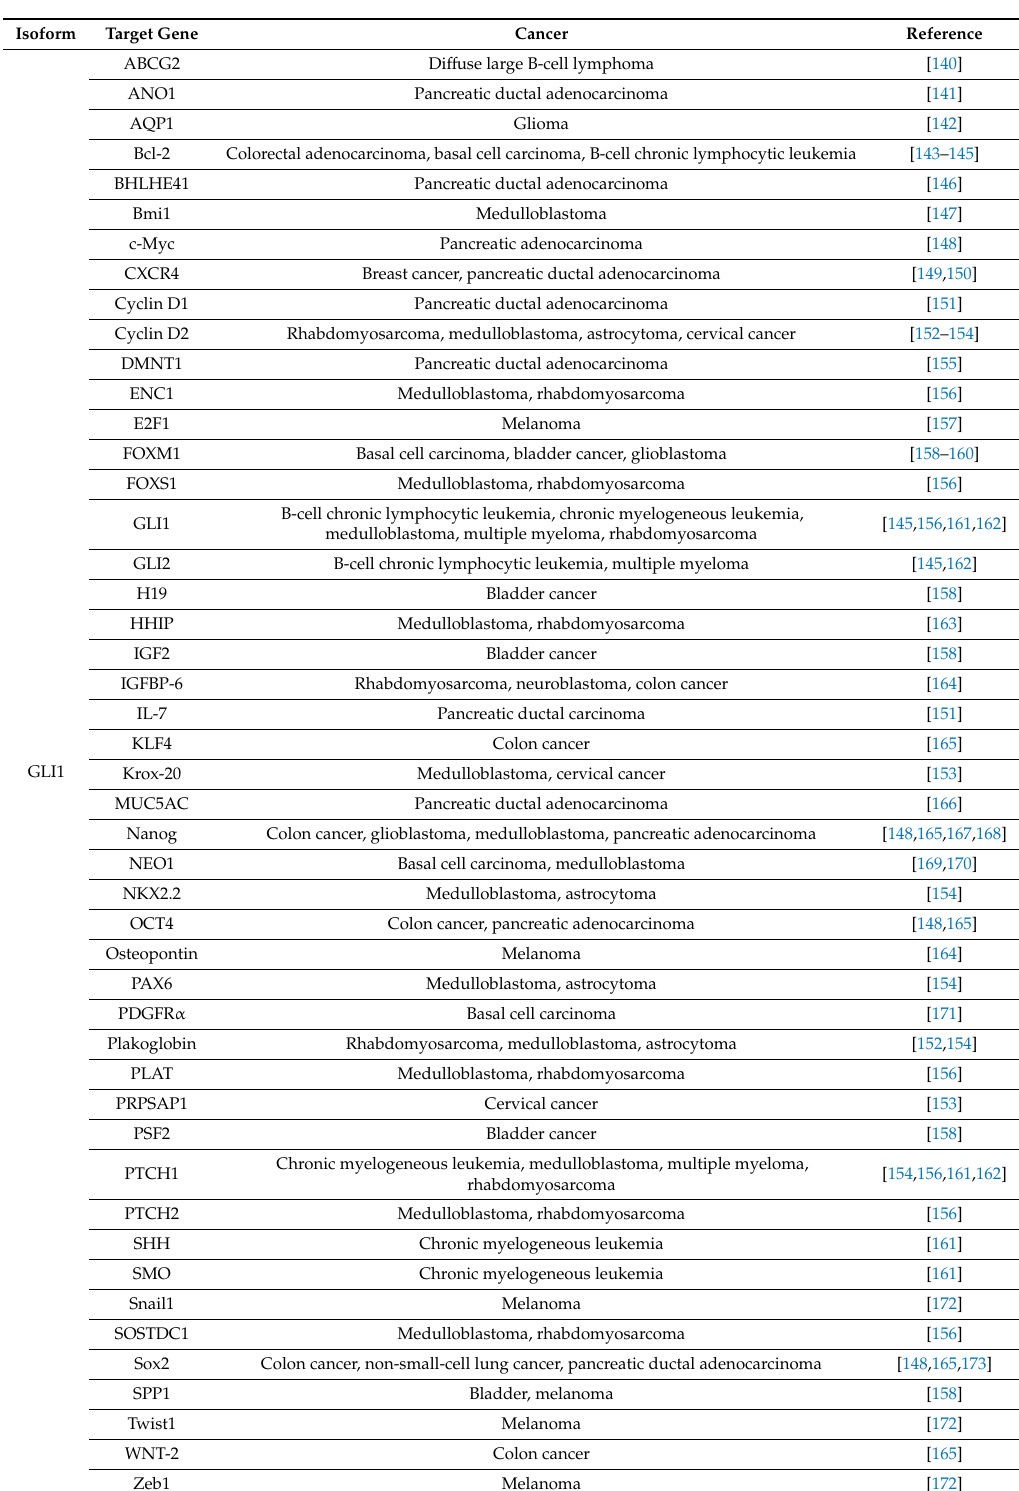
Table 1. Known target genes of GLI1 isoforms in human